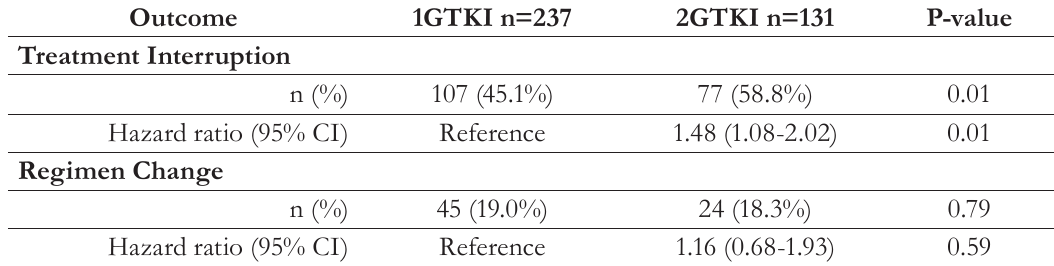
Table 2. Treatment Interruption and Regimen Changes by TKI Treatment Group